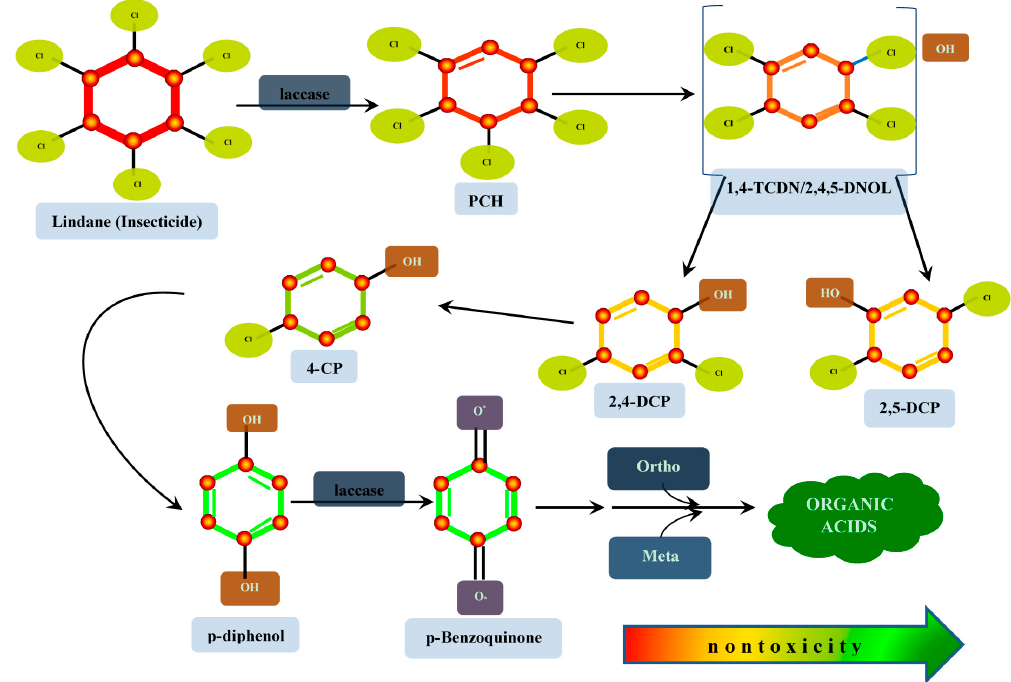
Figure 3. Hypothetical degradation of the insecticide, lindane, and its pathway to the production of organic acids. The colour tint on the rings represents the gradual metamorophosis from recaltrance and toxicity to biodegradability and eco-friendliness.